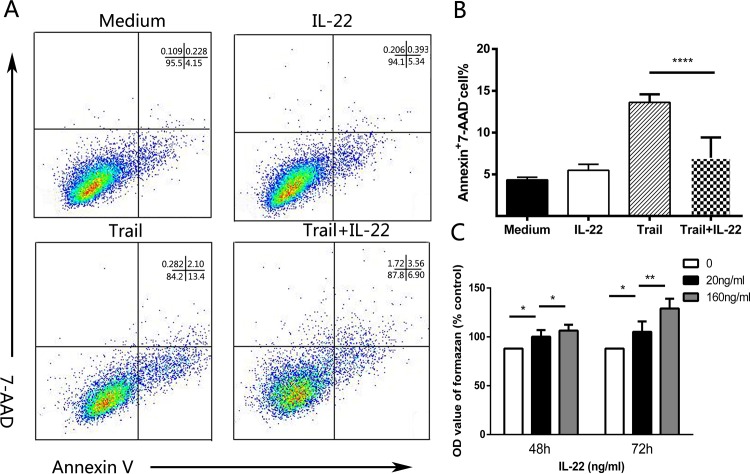
IL-22 in vitro inhibits the apoptosis and promotes the proliferation of HSCs.(A) Representative dot plots show the expression of 7-am-inoactinomycin D (7-AAD) and Annexin V in HSCs in vitro. Values of Annexin V+ and 7-AAD- represent the percentages of HSCs apoptotic cells. (B) Pooled data indicate that the addition of IL-22 significantly reduces the proportion of apoptotic cells. (C) Pooled data showed the OD value of formazan in HSCs supernatant at various IL-22 concentrations (20, 40 ng/mL) for 48h or 72h. *P < 0.05, **P < 0.01, ***P < 0.001, **** P < 0.0001, ns p>0.05.